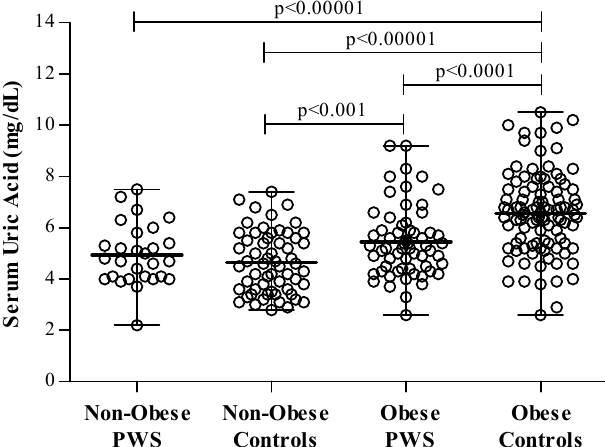
Figure 1. Scatter dot plot (mean and ranges) of serum uric acid levels in PWS and controls grouped as non-obese and obese (BMI ≥ 30 kg/m 2 ).